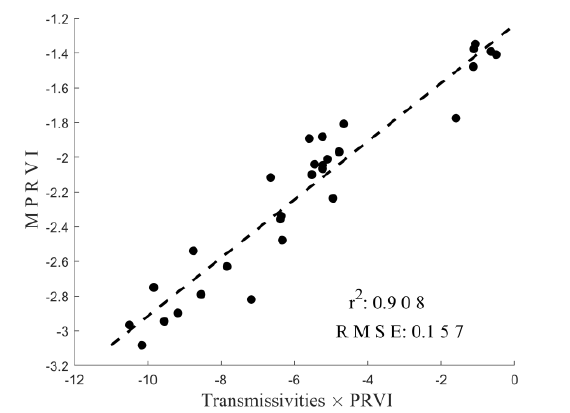
Figure 3 . Correlation between the multiplying PRVI with the characteristic of transmissivity (equation 7) and the MPRVI (equation